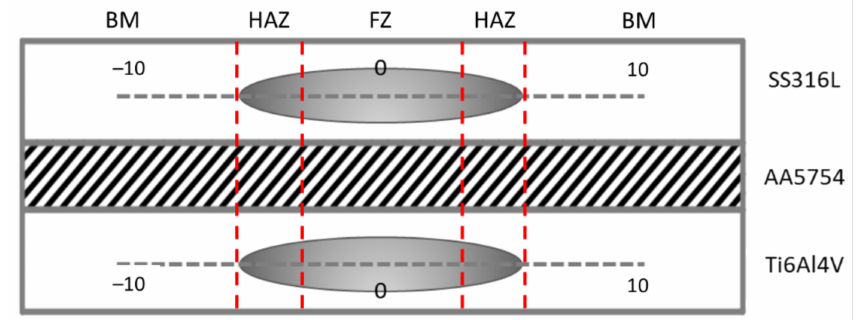
Figure 1. Microhardness measurement configuration.